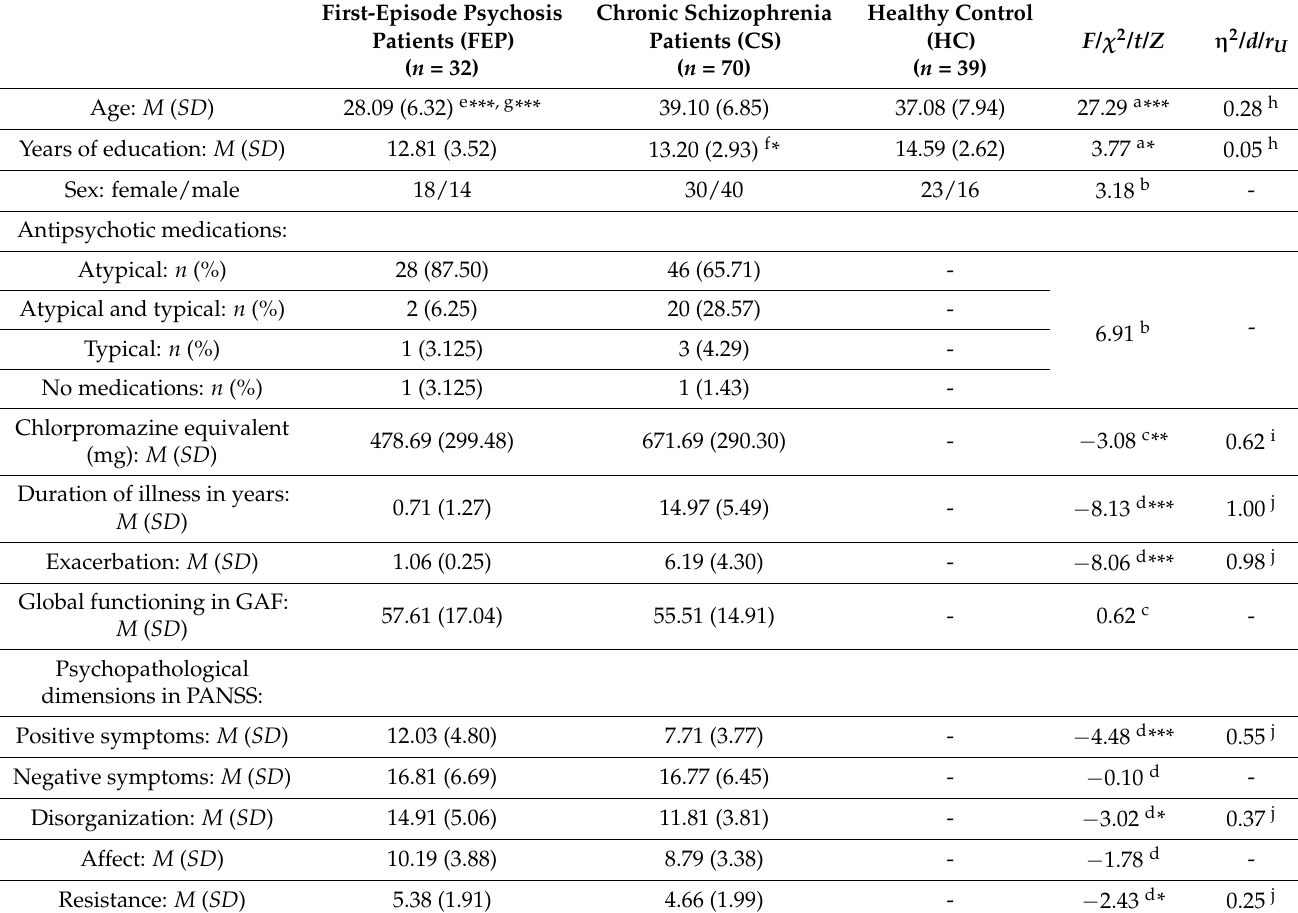
Table 2. Demographic and clinical characteristics of participants from three